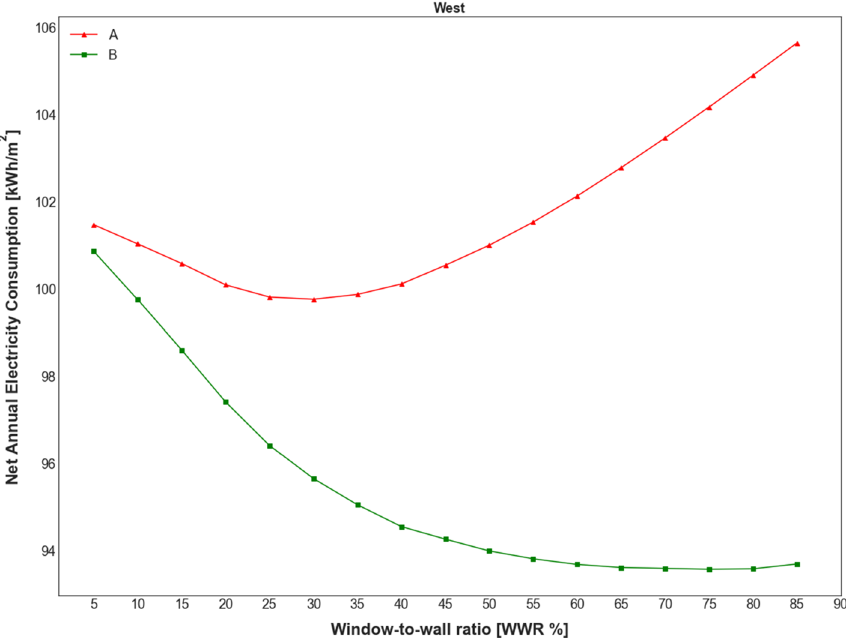
Fig. 4 Graphical comparison of net annual electricity consumption between two window systems